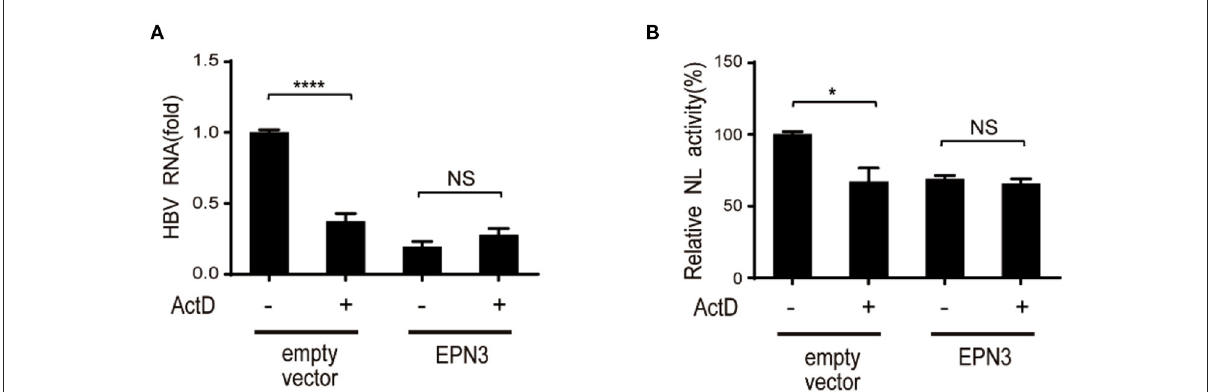
FIGURE4 EPN3-mediated HBV downregulation depends on transcription. (A) Huh7 cells were transfected with pPB and the EPN3 expression vector. 54h later, 100ng/ml actinomycin D (ActD) was added for 18h to block transcription. Total RNA was extracted to measure by RT-qPCR. The level of the empty vector without ActD treatment sample is defined as value 1. (B) Huh7 cells were transfected with EPN3, pCMV1.2xHBV/NL and pcDNA-CP. ActD was added 18h before harvest, followed by luciferase assay. The NL activity of the empty vector without ActD treatment sample is defined as value 100. * P < 0.05, **** P < 0.0001. Data are representative of two to three independent experiments.